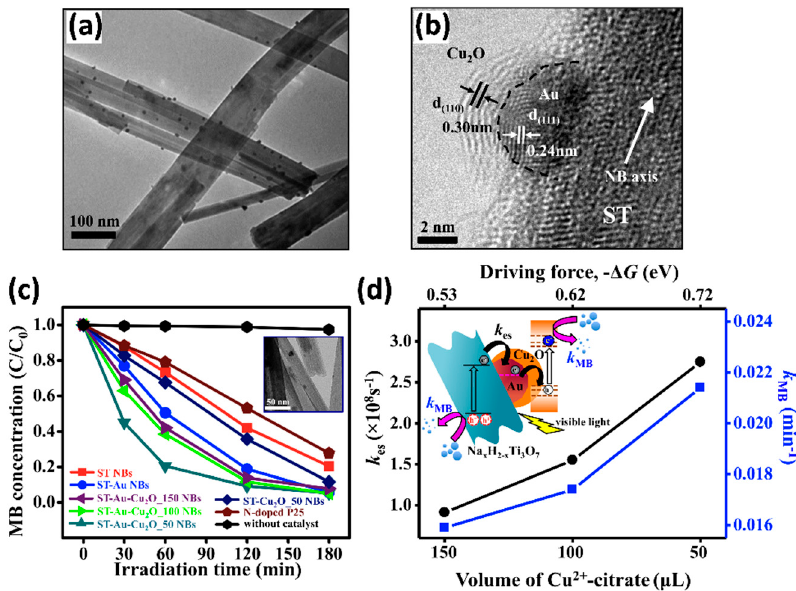
Figure 14. TEM images of ( a ) ST–Au and ( b ) ST–Au–Cu 2 O NBs. ( c ) Photodegradation of MB on relevant photocatalysts under visible irradiation (inset shows the TEM image of ST–Cu 2 O NBs). ( d ) Correlations of k es and k MB with the amount of Cu 2+ –citrate and the driving force ( −Δ G) of interfacial electron transfer for ST–Au–Cu 2 O (reproduced with permission from [87] . Copyright Elsevier Science Publishers, 2015.).